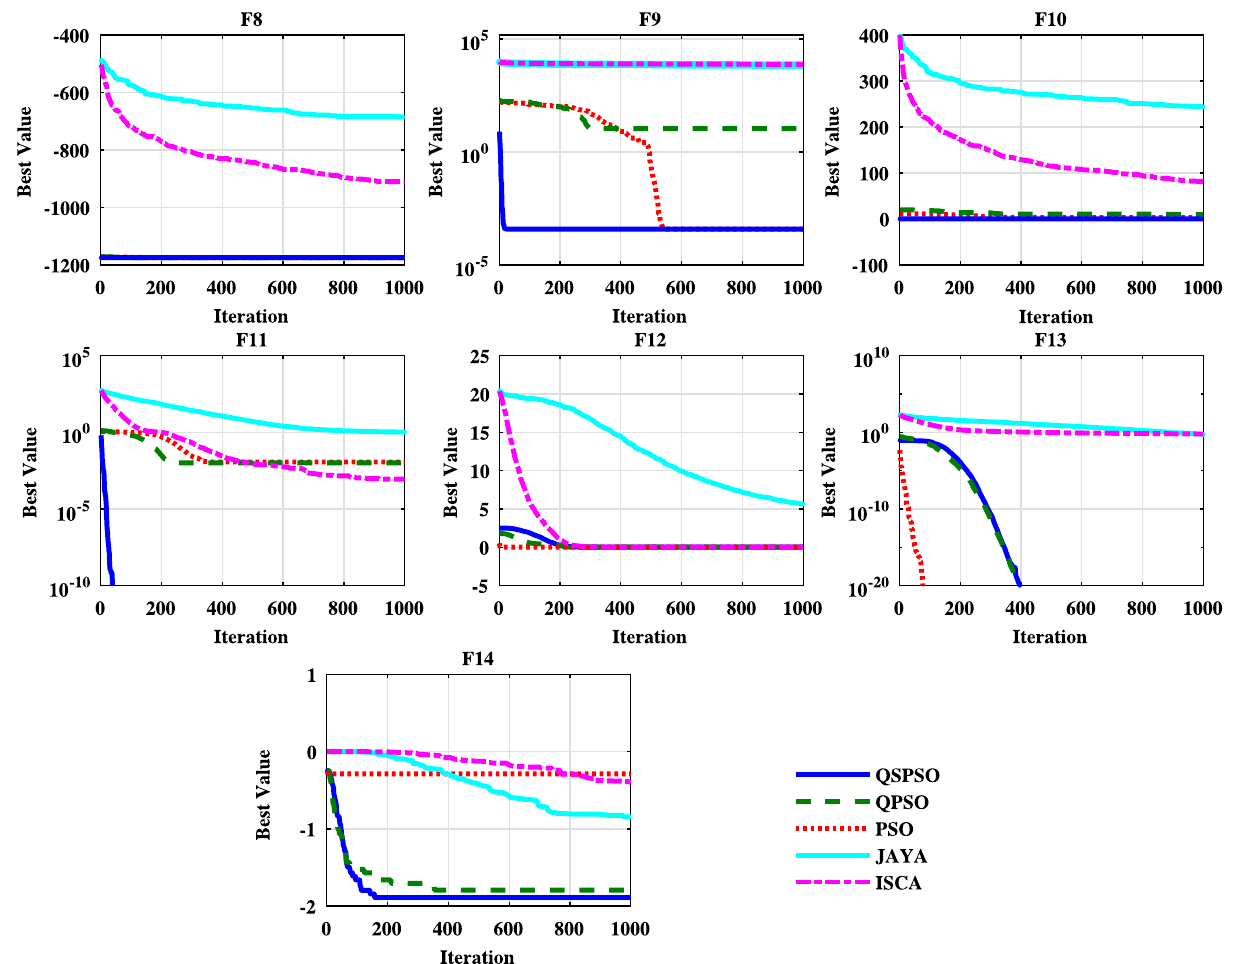
Figure 6. Convergence curves of the multimodal test